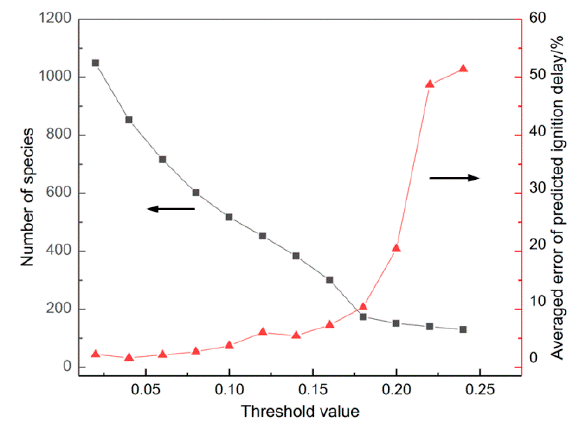
Figure 1. The results of species number and averaged error under different threshold value.